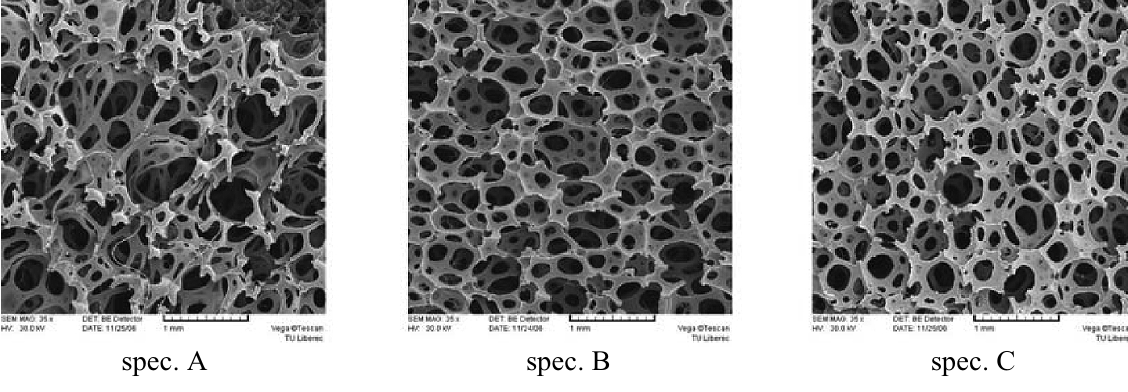
Fig. 1. Structure of polyurethane foam specimens with different density.